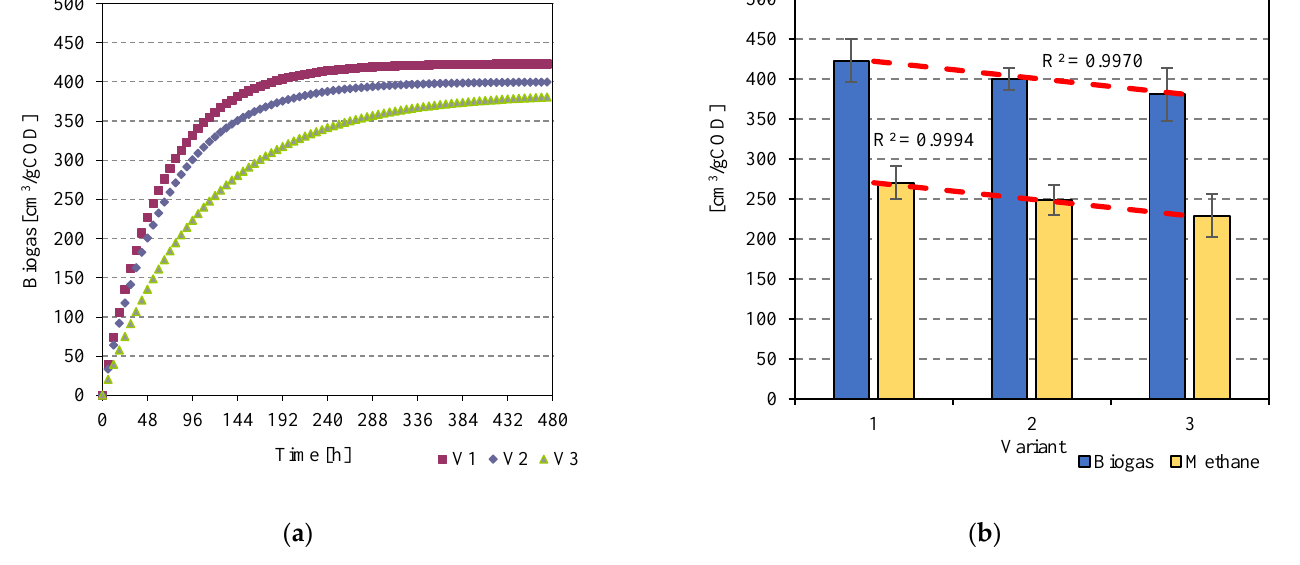
Figure 2. The course of AD process ( a ) and correlations between OLRs applied and biogas and methane yields ( b ) achieved in S0.